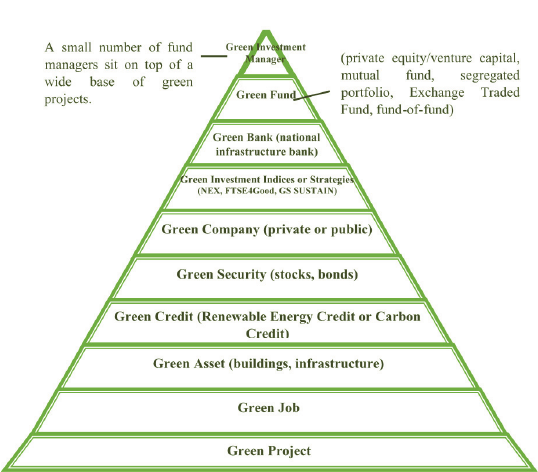
Fig. 1. Green investment pyramid (Source: Inderst et al.